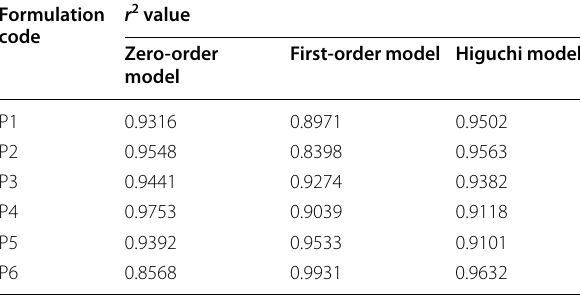
Table 2 Results of release kinetic models of various chitosan- based PEC beads containing Diclofenac sodium (1–6 h) Formulation code